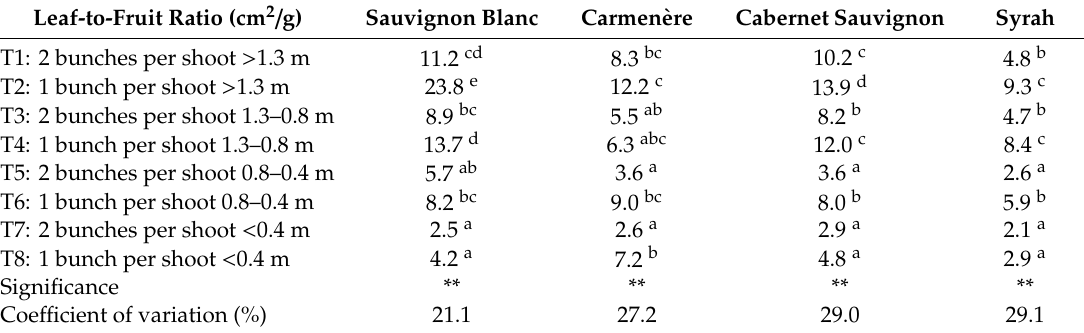
Table 2. Leaf-to-fruit ratios (cm 2 / g) in cv. “Sauvignon blanc”, “Carmen è re”, “Cabernet Sauvignon”, and “Syrah” according to length of shoot and crop